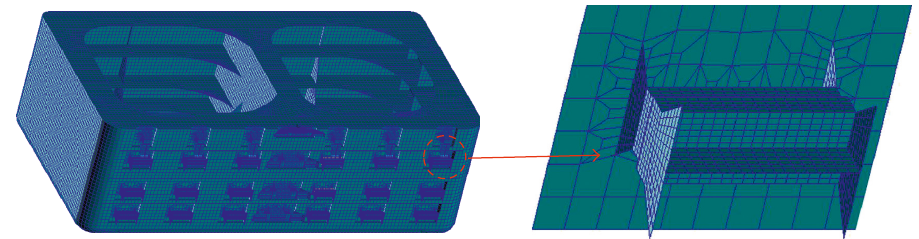
Figure 5: Fine mesh generation of the tank support structure.